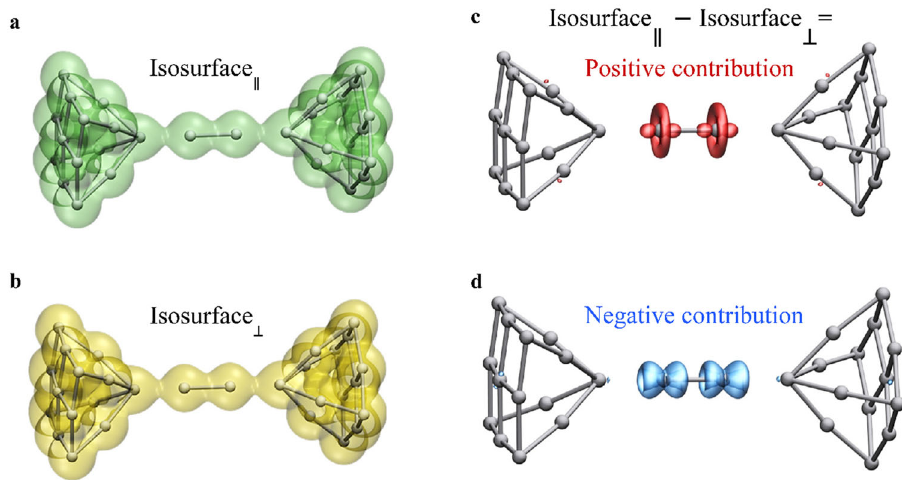
Fig. 5 Calculated spatial distribution of the charge density for a short Pt atomic wire junction. a , b Isosurfaces of 1.6 Bohr − 3 charge density for parallel ( a ; green) and perpendicular ( b ; yellow) magnetizations. c , d Isosurfaces of positive ( c ; red) and negative ( d ; blue) charge density differences between the parallel and perpendicular magnetizations isosurfaces. The positive and negative components in ( c , d ) reveal variations in the orbital contribution to the total charge density when changing the magnetization